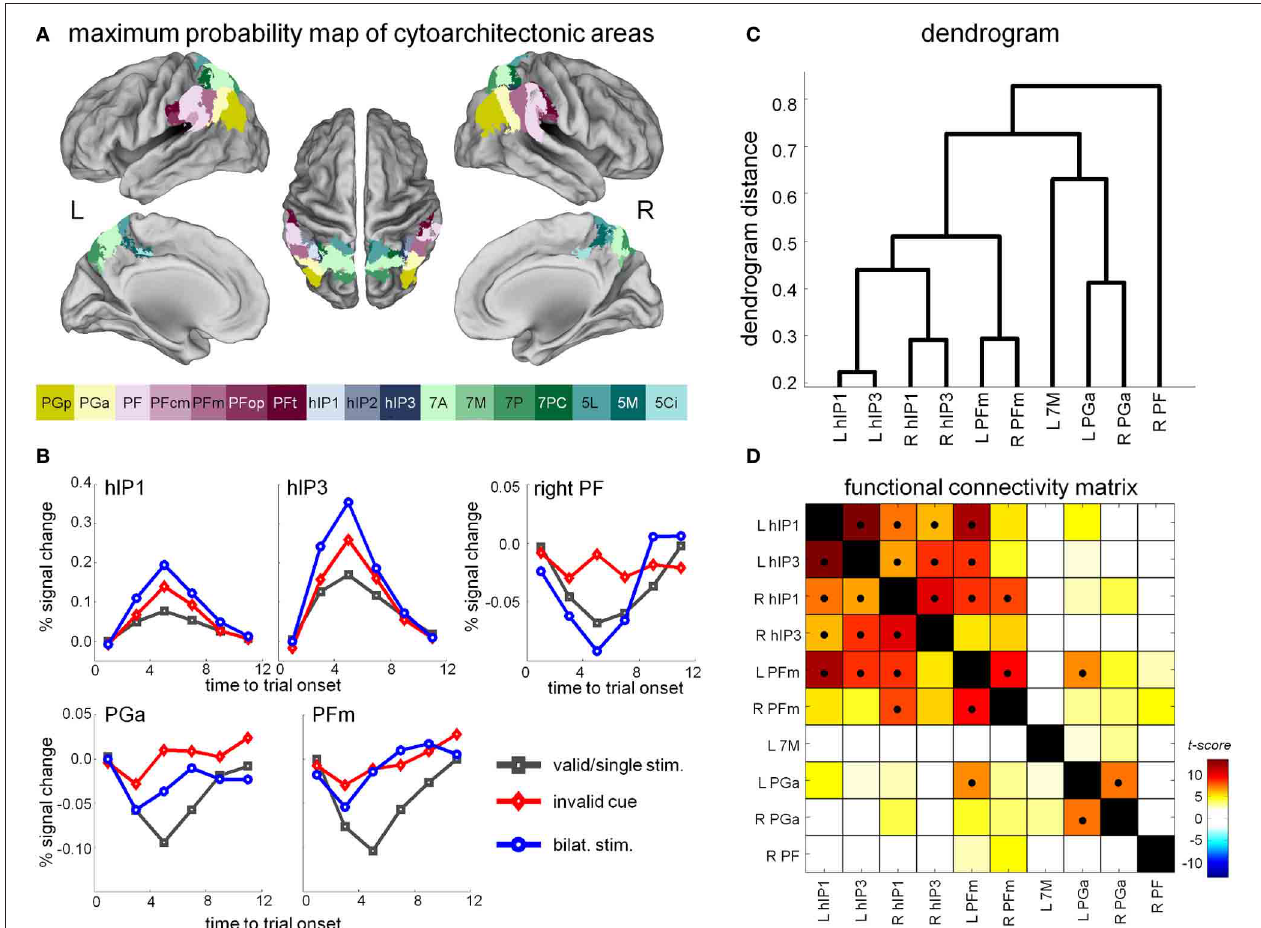
showed a significant competition or invalidity effect in the hybrid spatial cueing paradigm. (D) Functional connectivity matrix. The cross-correlation matrix is sorted on the basis of the hierarchical clustering results, so that adjacent VOIs have the most similar connectivity profiles. Significant correlations ( P < 0 . 05, Bonferroni-corrected for the number of pairwise comparisons) are indicated by a black